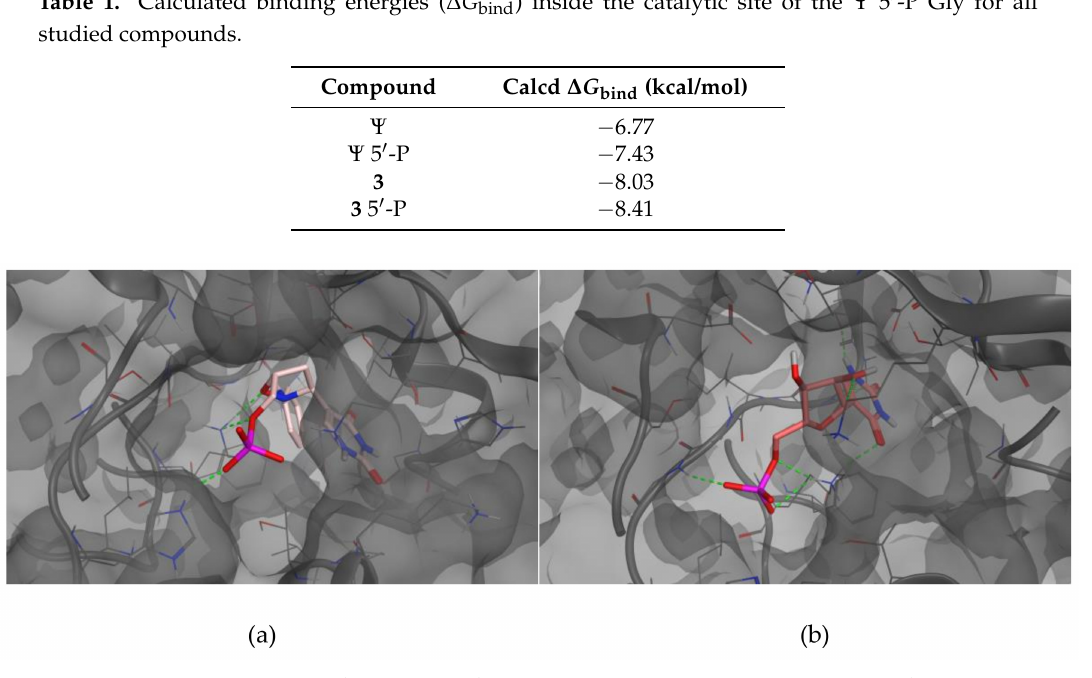
Figure 2. Docked pose of 3 5 (cid:48) -P inside Ψ 5 (cid:48) -P Gly ( a ) and Docked pose of Ψ inside Ψ 5 (cid:48) -P Gly ( b